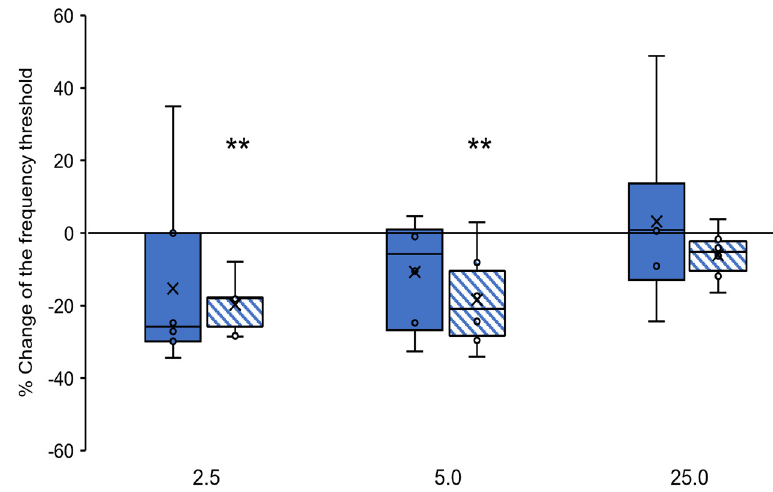
Figure 4. Percent change of the frequency threshold in the feeding response (FR) during unilateral electrical VTA stimulation (Es-VTA) directly after different doses of naloxone (2.5 µ g/0.5 µ L, 5.0 µ g/0.5 µ L, or 25.0 µ g/0.5 µ L) injected into the PPN in the contralateral (blue-filled bars) and ipsilateral hemisphere (blue-hatched bars) (n = 6 for each dose) compared to artificial cerebrospinal fluid (ACSF; a value of 0.0% on the y-axis) injection into the PPN as baseline control. Tukey’s post hoc test: ** p < 0.01 indicates a significant difference between the experimental groups (2.5 and 5.0 µ g doses) compared to the baseline (Ni groups vs. baseline).